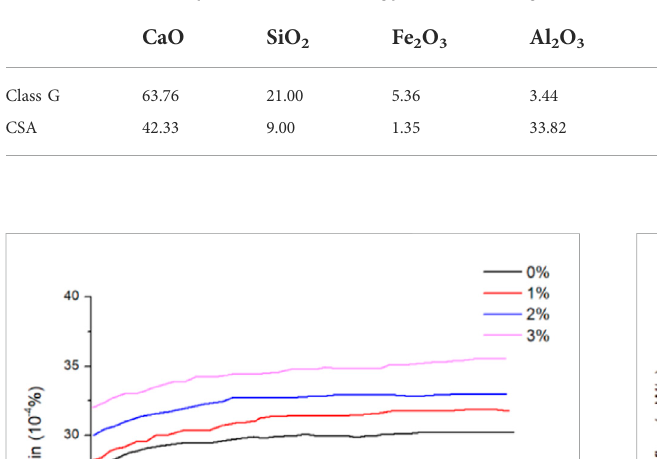
TABLE 1 Chemical compositions of different types of cement (by wt.%).